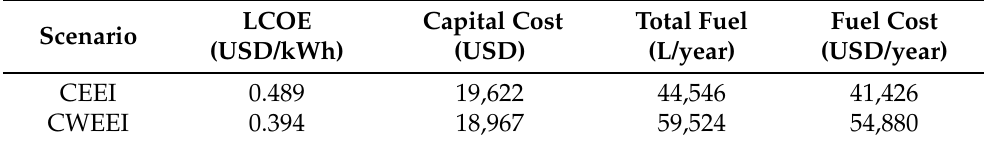
Table 5. Operational and economic values for the CEEI and the CWEEI over the planning